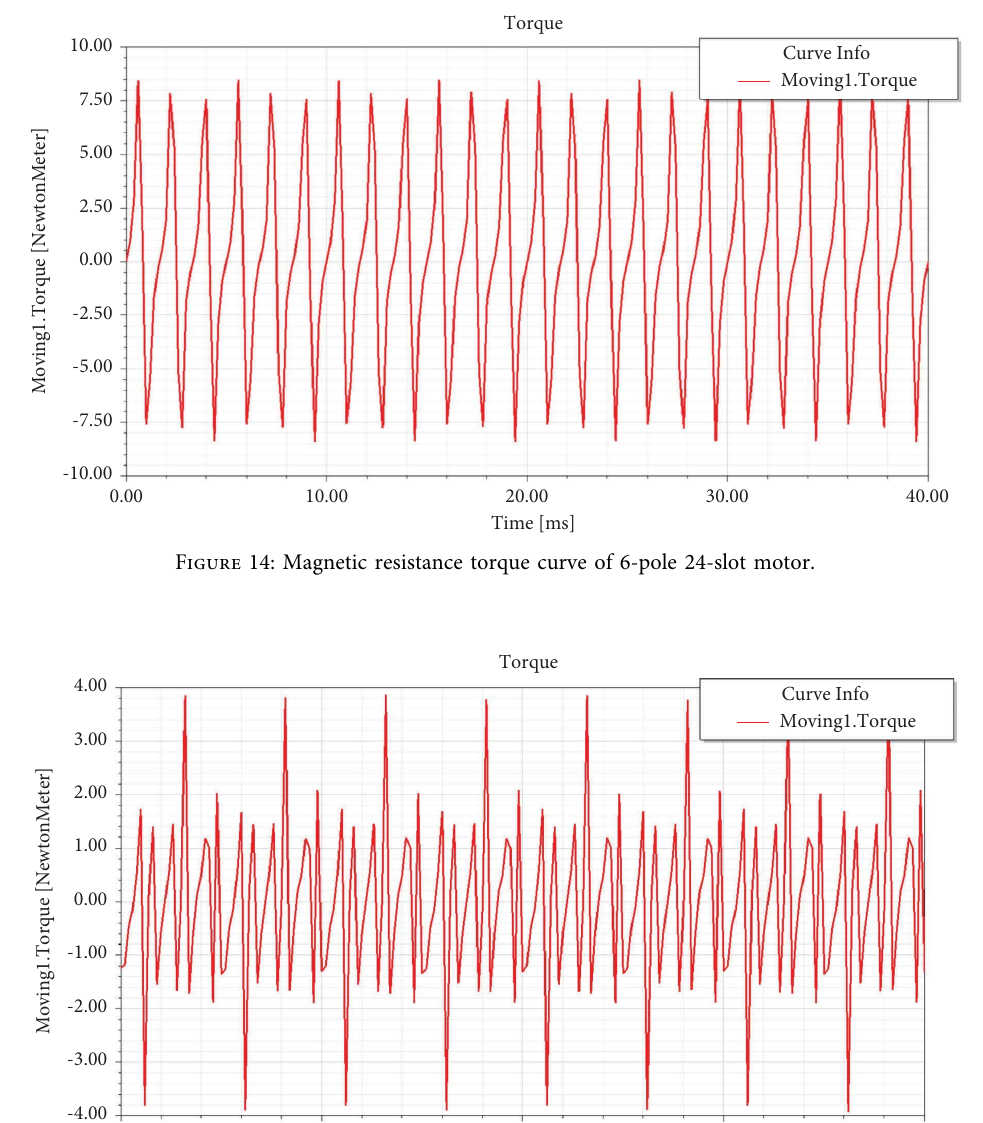
Figure 15: Magnetic resistance torque curve of 8-pole 24-slot